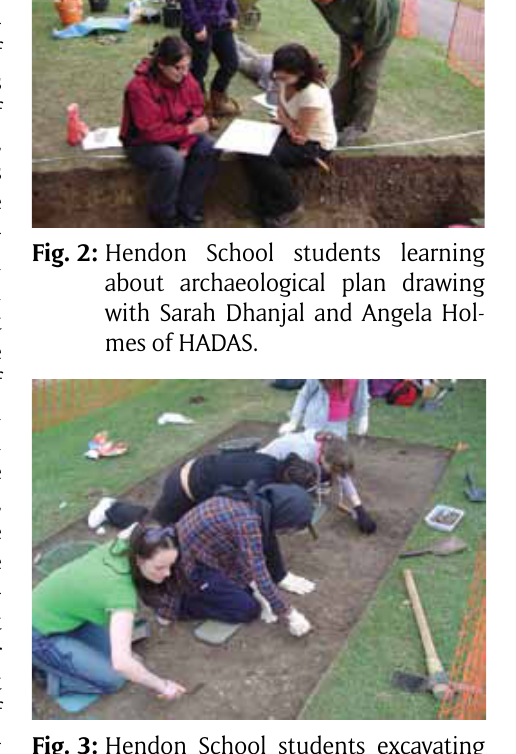
Fig. 3: Hendon School students excavating their